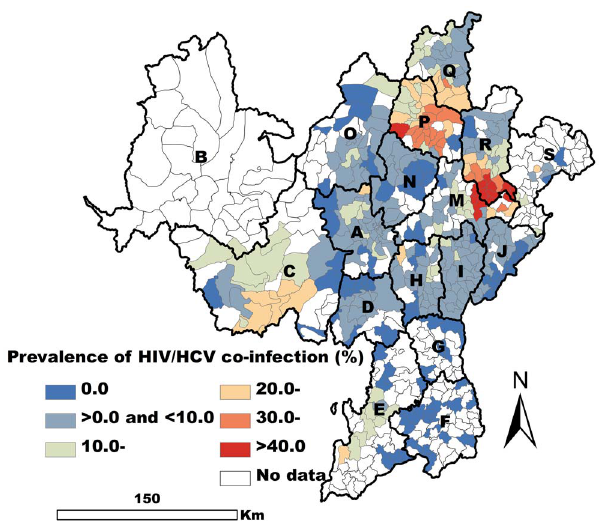
Figure 5. Spatial EB smoothed map of the prevalence of HIV/ HCV co-infection by township.